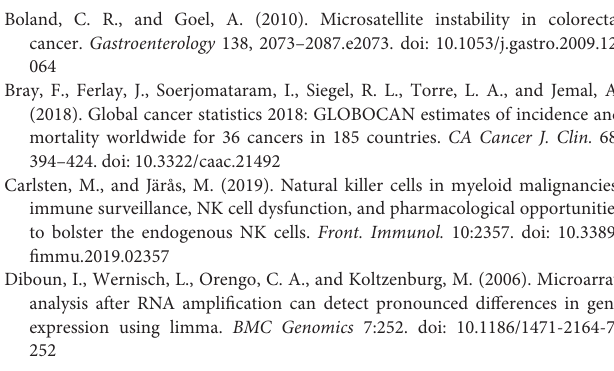
Supplementary Figure 1 | Association of PIMREG expression with gender in various cancers. Supplementary Figure 2 | Association of PIMREG expression with age in various cancers. Supplementary Figure 3 | Association of PIMREG expression with age in various cancers. Supplementary Figure 4 | Association between the expression of PIMREG and tumor stage in various cancers. Supplementary Figure 5 | Correlation between PIMREG and stromal scores in various cancer types. Supplementary Figure 6 | KEGG and GO pathway analysis of PIMREG in various